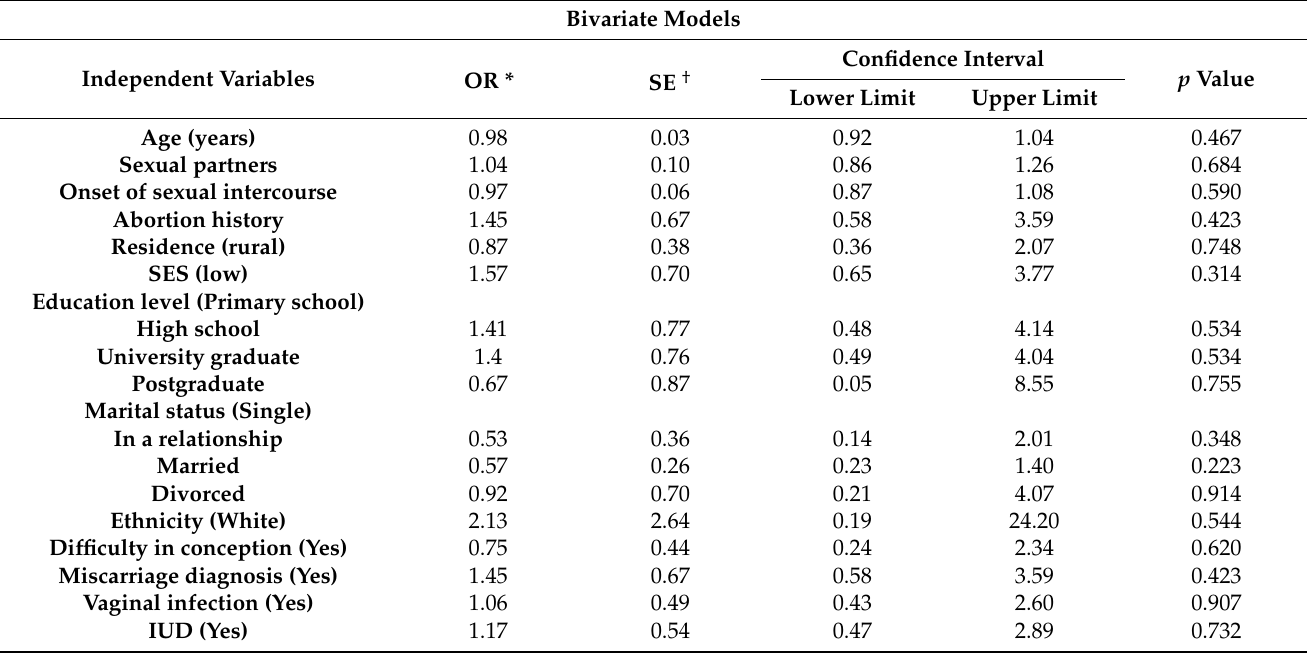
Table 3. Bivariate logistic regression ( n = 102). Bivariate